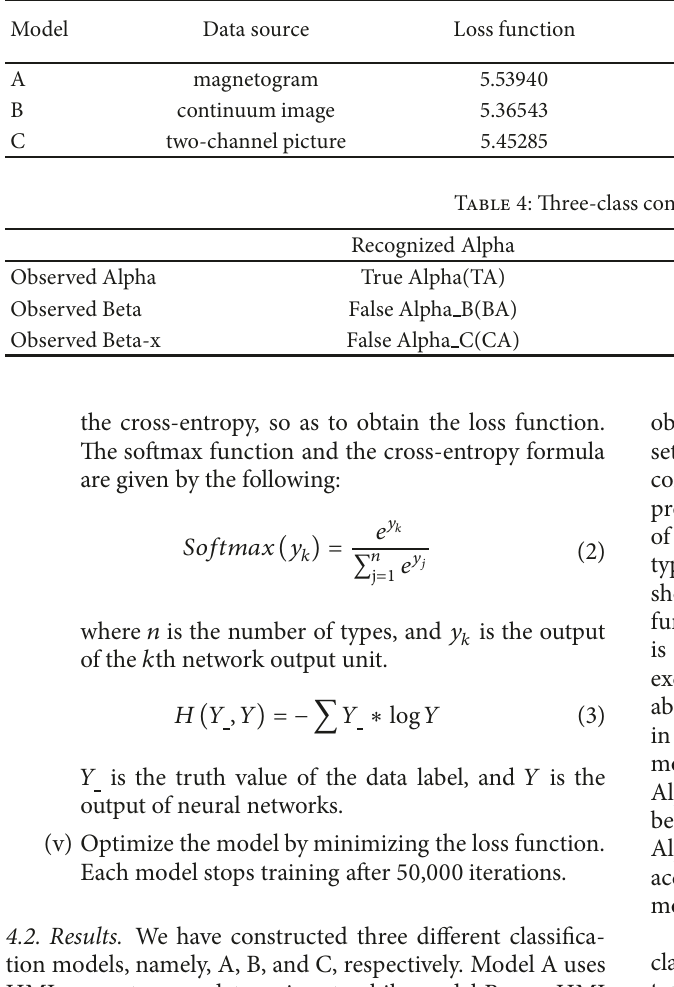
Table 3: Performance of each training model.